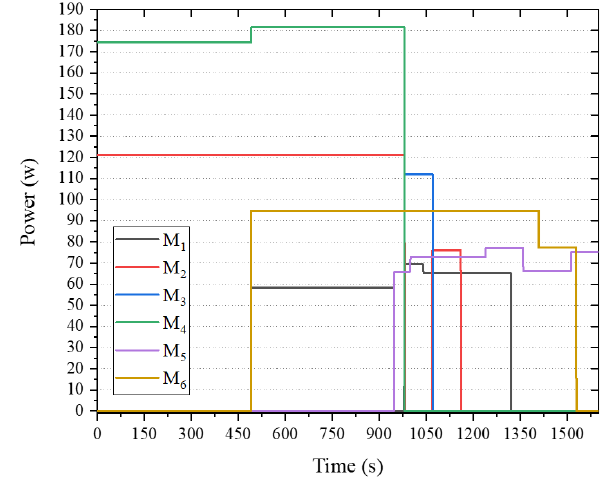
Figure 24. Simulation machining power curve.